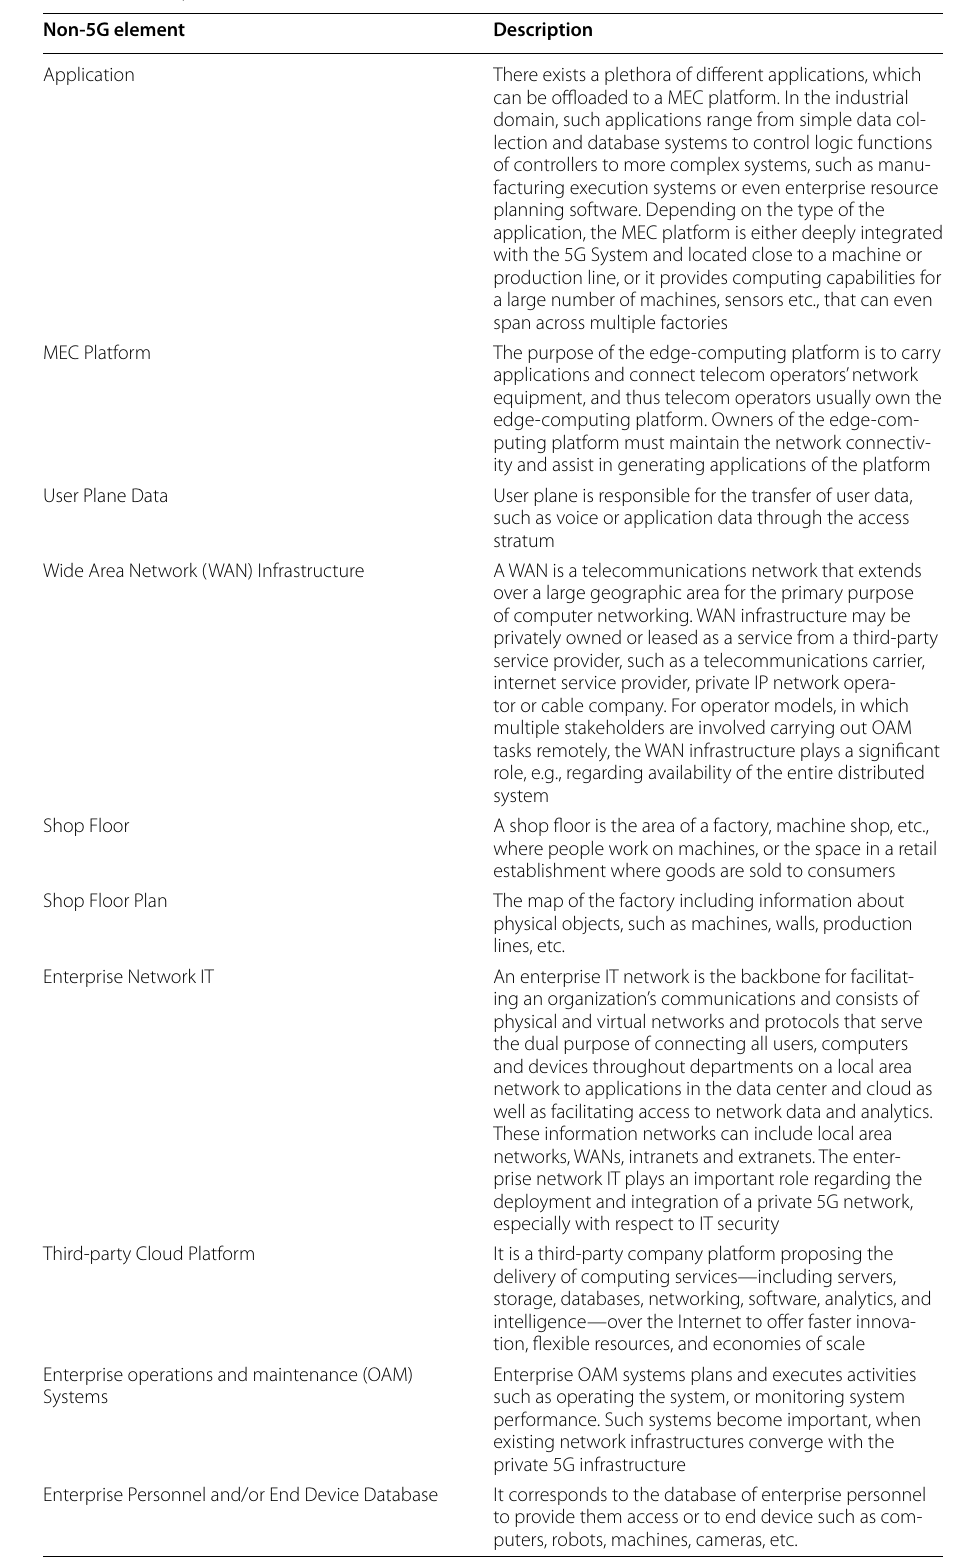
Table 5 Description of non‑5G element Non-5G